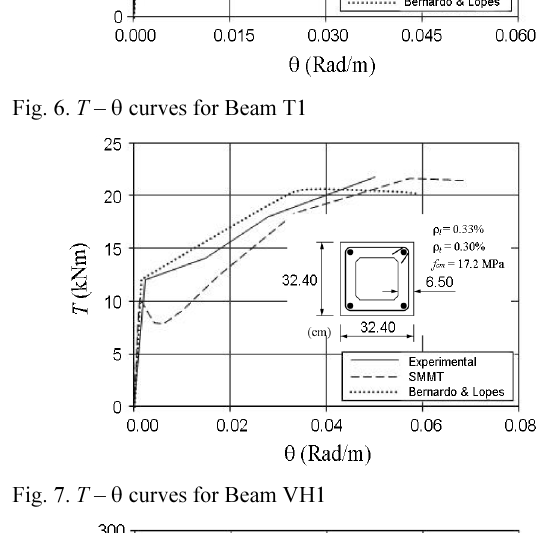
Fig. 7. T – θ curves for Beam VH1